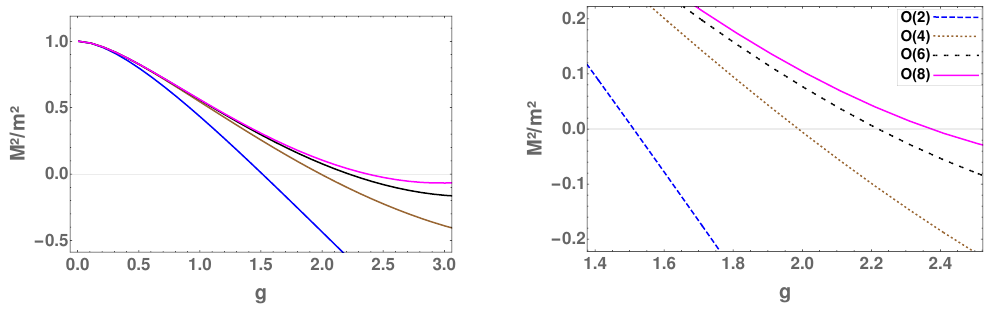
Figure 3 . Left panel: the physical mass squared, in units of m 2 , as a function of g at even orders. Right panel: same as the left panel but zoomed.